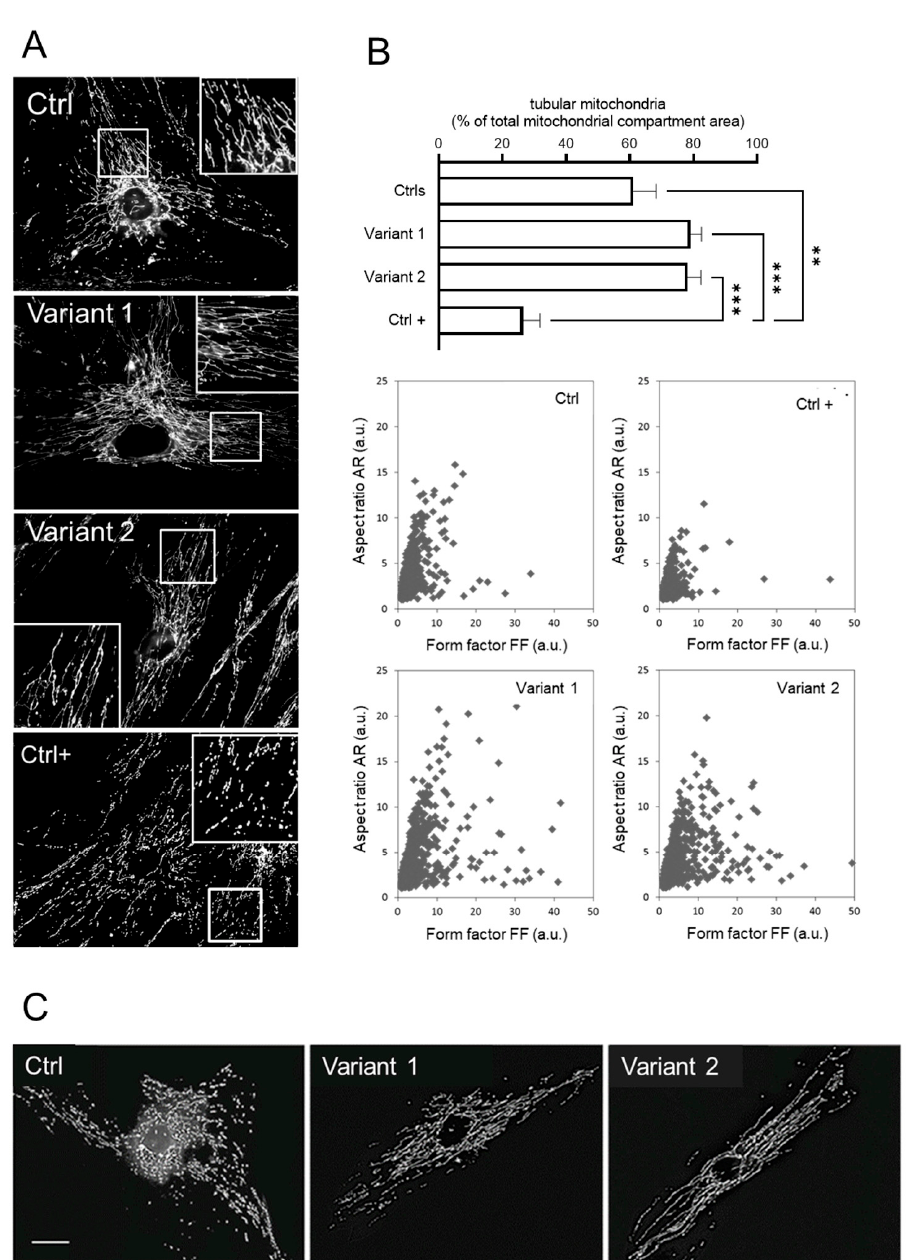
Figure 4. Mitochondrial morphology investigations in skin fibroblasts. ( A ) The mitochondrial net- work analysis by fluorescence microscopy showed hyperfused tubules in REEP1 mutated fibroblasts as compared with control. A control line under the effect of FCCP was used as positive control of the fragmented network (Ctrl +). ( B ) Morphometric analysis showing a significant increase in tubular mitochondria in patients. Statistics was assessed by ordinary ANOVA test (one-way ANOVA). ** p <